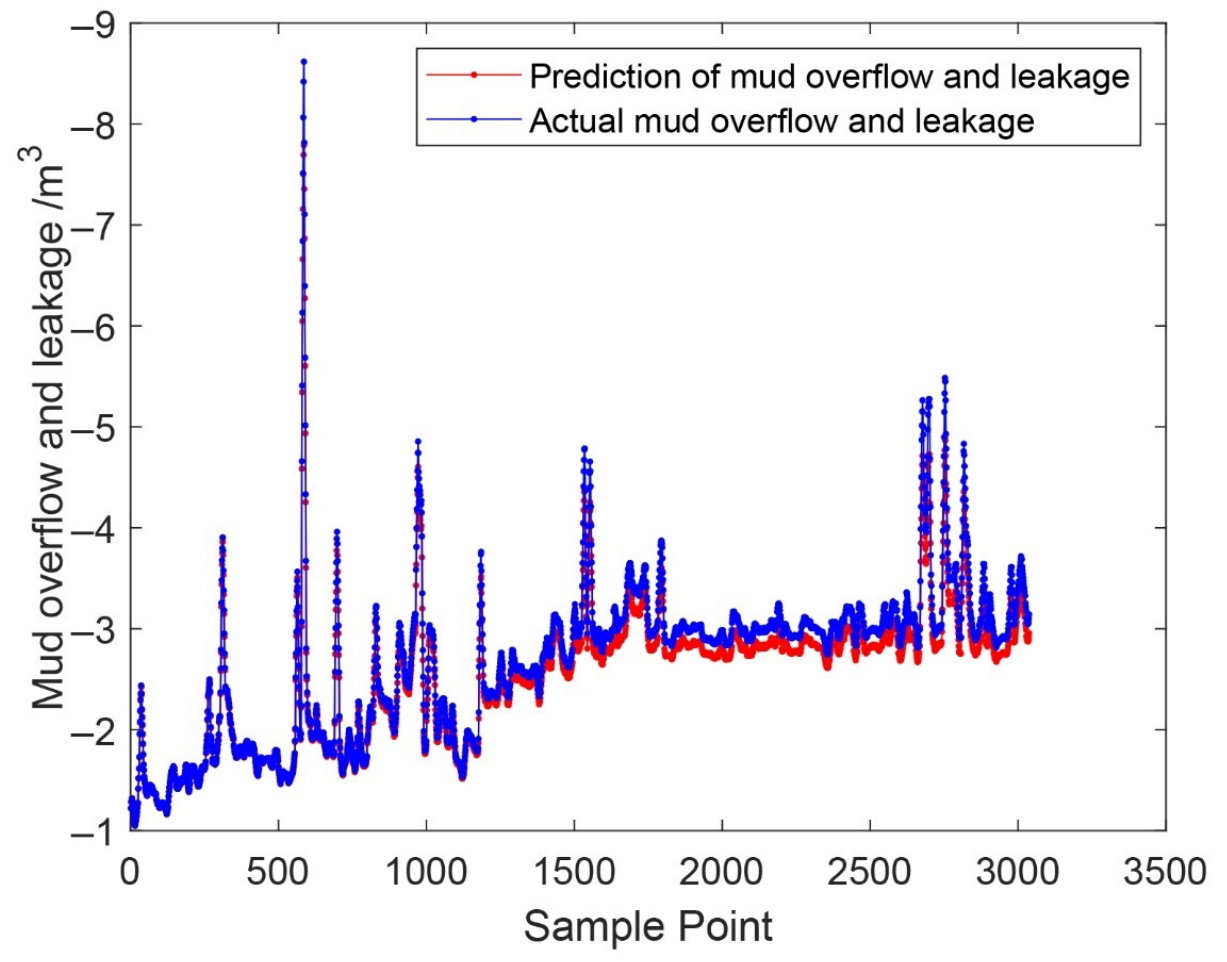
Figure 5. Mud overflow and leakage prediction results using GA-BP neural network.